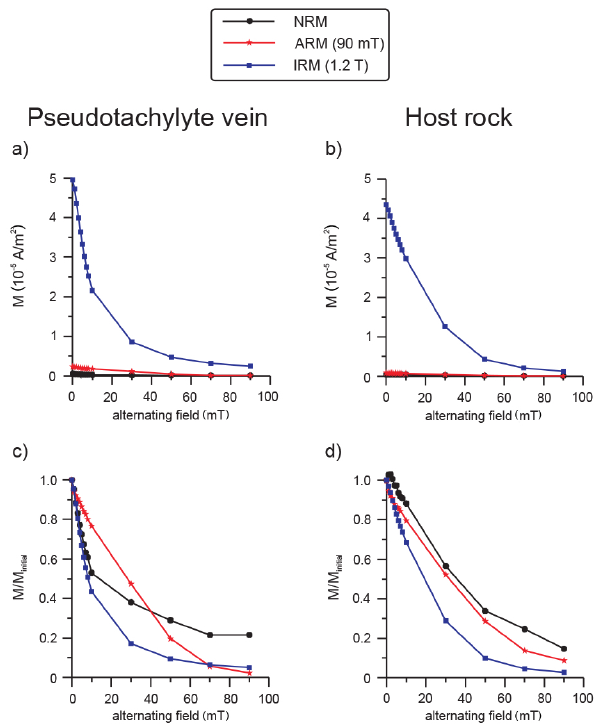
Fig. 8. Rock magnetic measurements. Alternating field demagneti- sations of NRM, ARM and IRM of pseudotachylyte and host rock. Shown are first (a, b) magnetisation versus alternating field, then (c, d) normalised magnetisation (normalisation using initial magnetisa- tion at 0mT alternating field) versus alternating field. NRM of the pseudotachylyte is analogue to an IRM while the NRM of the host rock is analogue to an